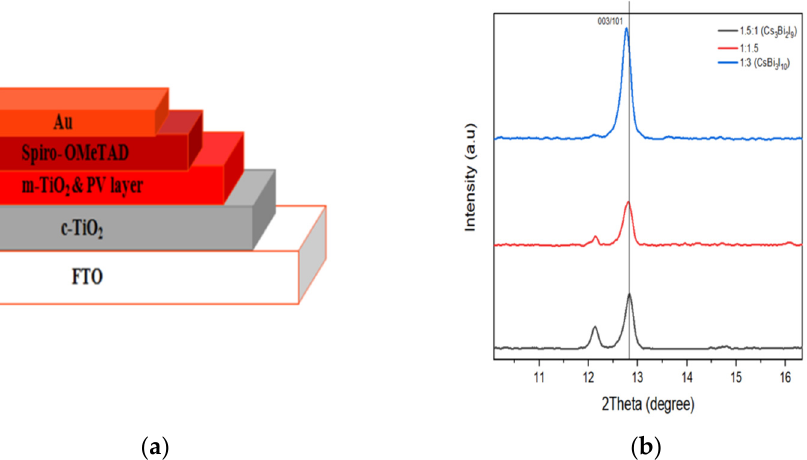
Figure 8. ( a ) Solar cell configuration; ( b ) XRD comparison for molar ratio 1:1.5, 1.5:1 and 1:3.